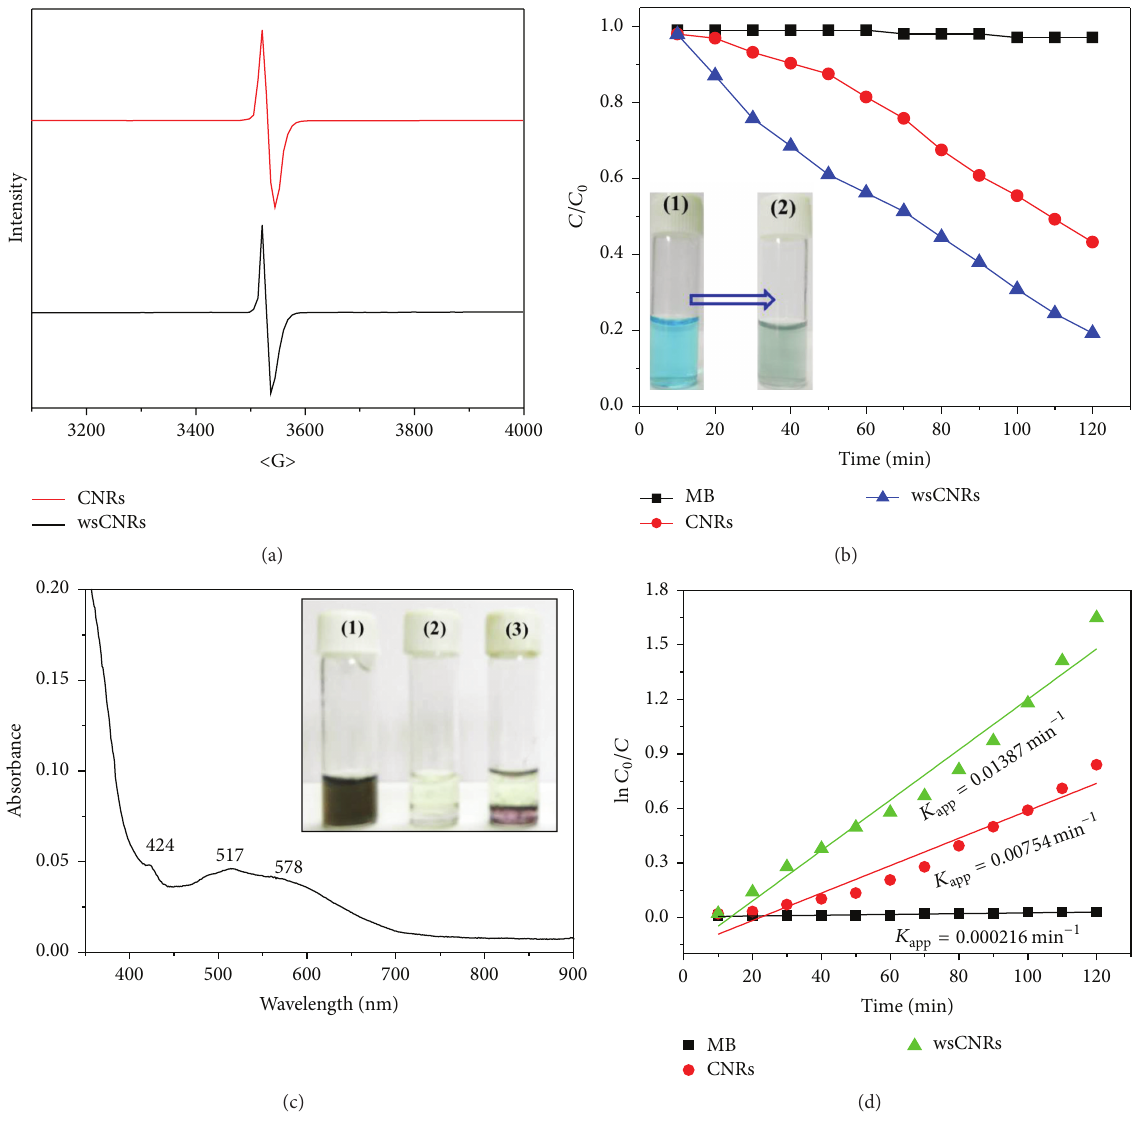
Figure 3: (a) EPR spectra of CNRs and wsCNRs showing the presence of high intensity carbon radical peak only; (b) photochemical degradation of MB in presence of only MB, CNRs, and wsCNRs under sunlight (inset photographs of ( 1 ) aqueous solution of MB); ( 2 ) complete photochemical degradation of MB after the addition of wsCNRs (120 minutes) to colorless solution; (c) UV-visible spectrum of the generation of ROS by wsCNRs showing the formation of diformazan dye (inset change in color of wsCNRs solution ( 1 ) before ( 2 ) and after ( 3 ) the addition of NBT upon photoirradiation); (d) corresponding plot of ln (𝐶 0 /𝐶) versus time for photochemical degradation of MB dye using only MB, CNRs, and